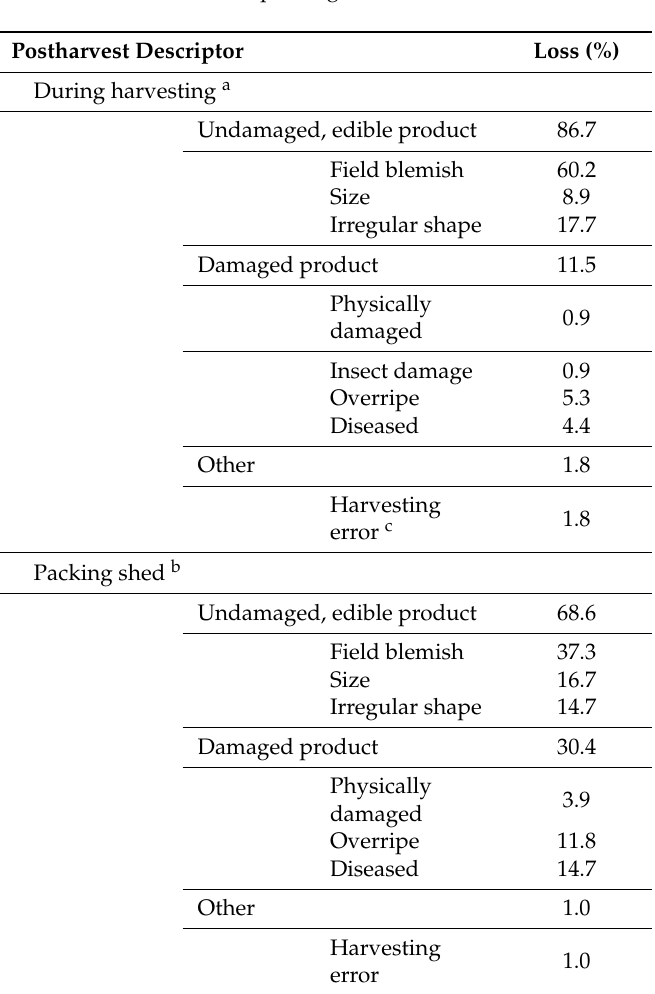
Table 6. Identified reasons for product being removed from the commercial supply chain, expressed as a percent of total losses in the field or in the packing